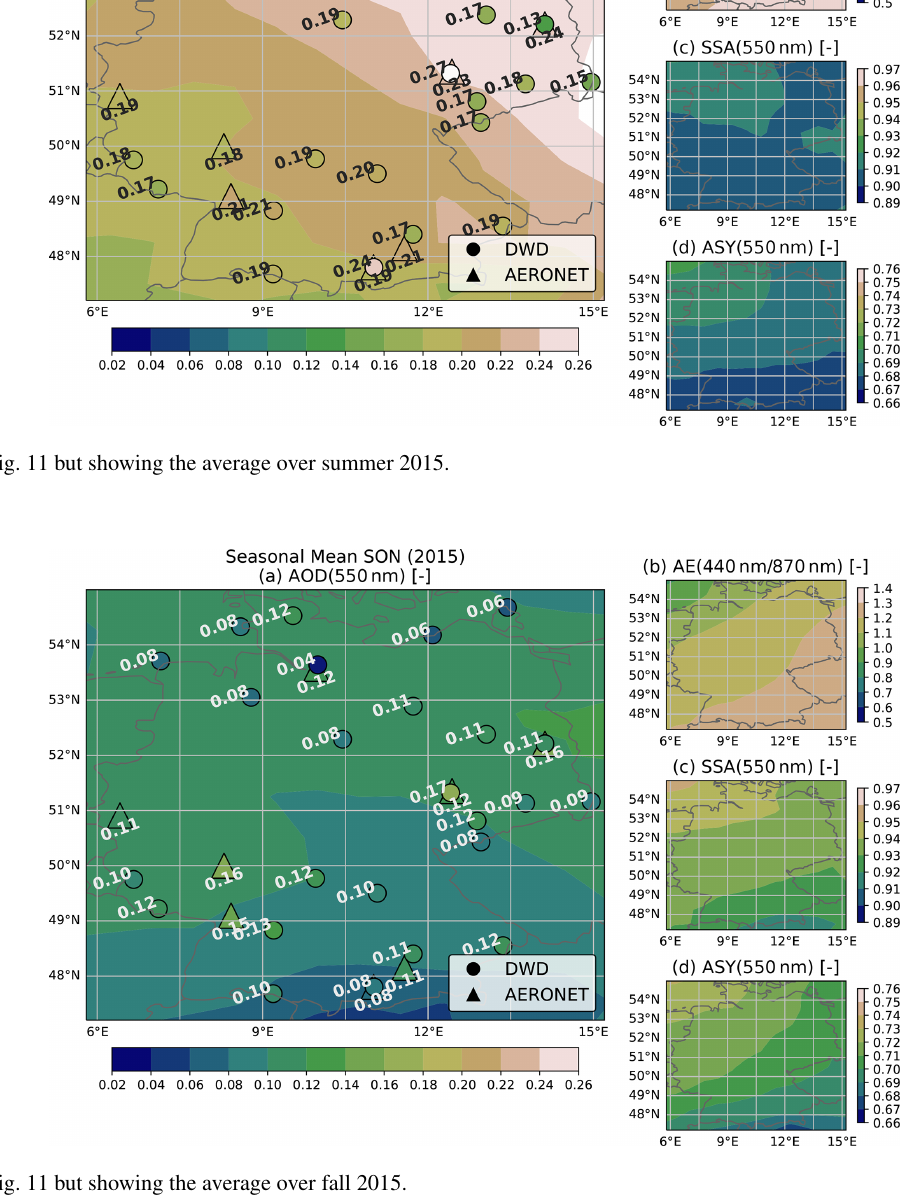
Figure D7. As Fig. 11 but showing the average over fall